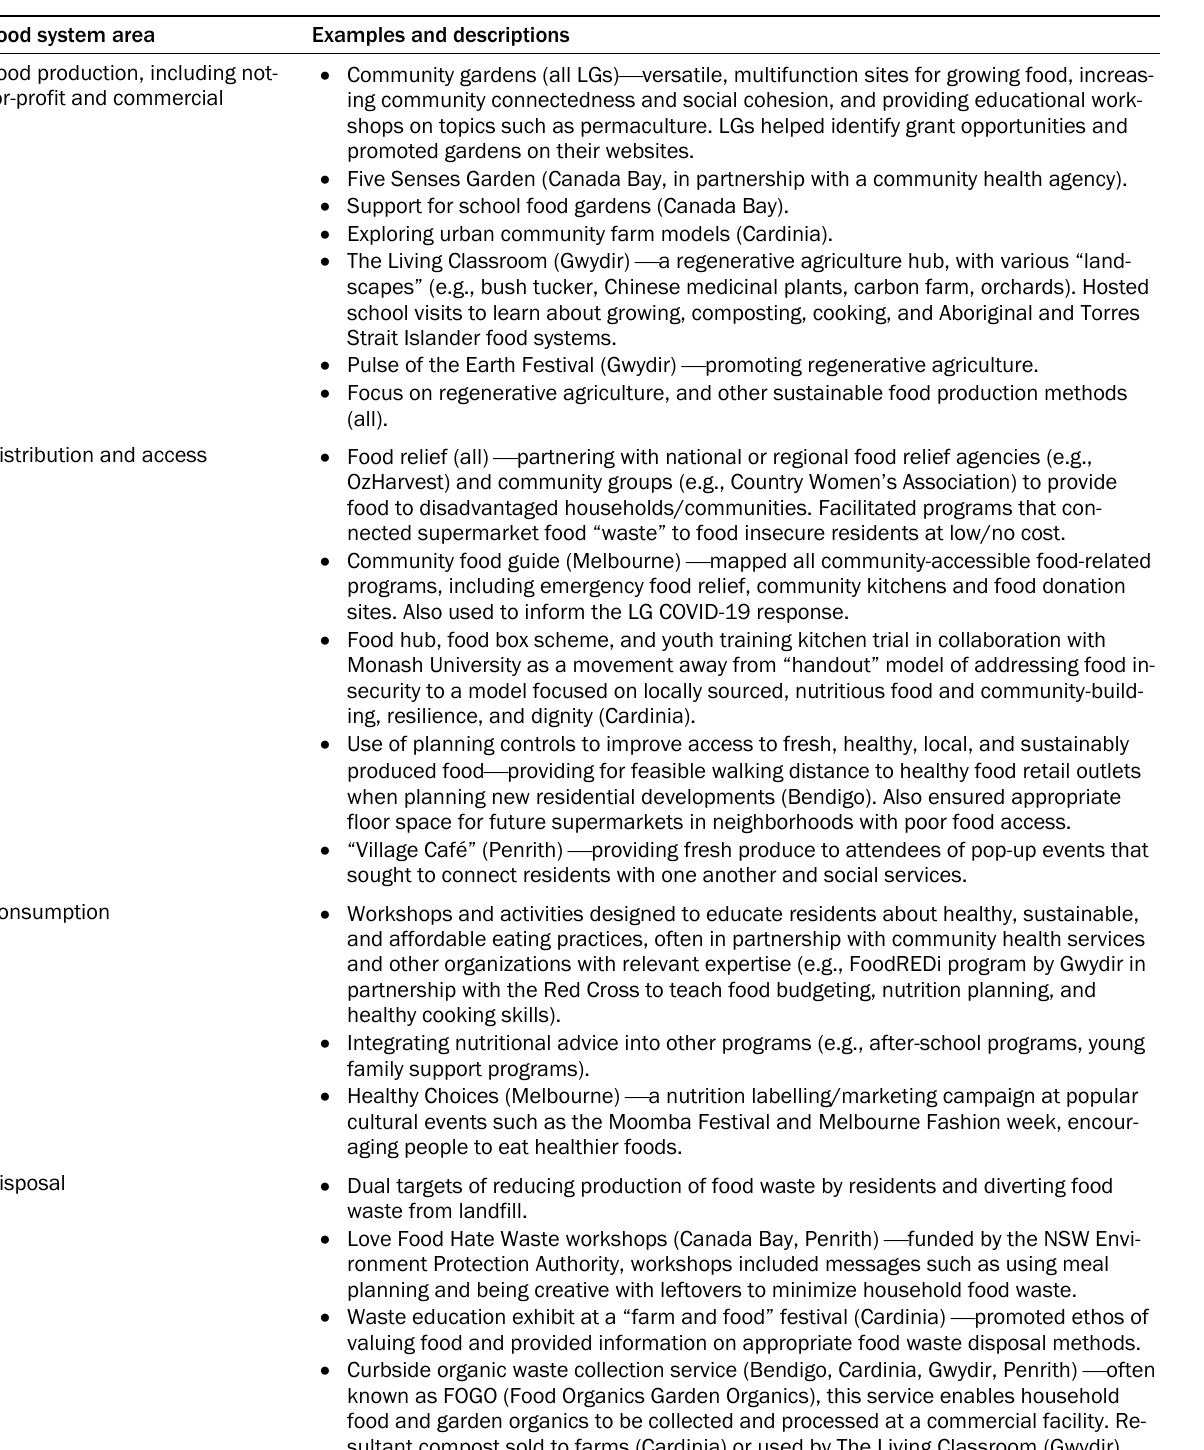
Table 2. Overview of Activities Implemented by LGs Food system